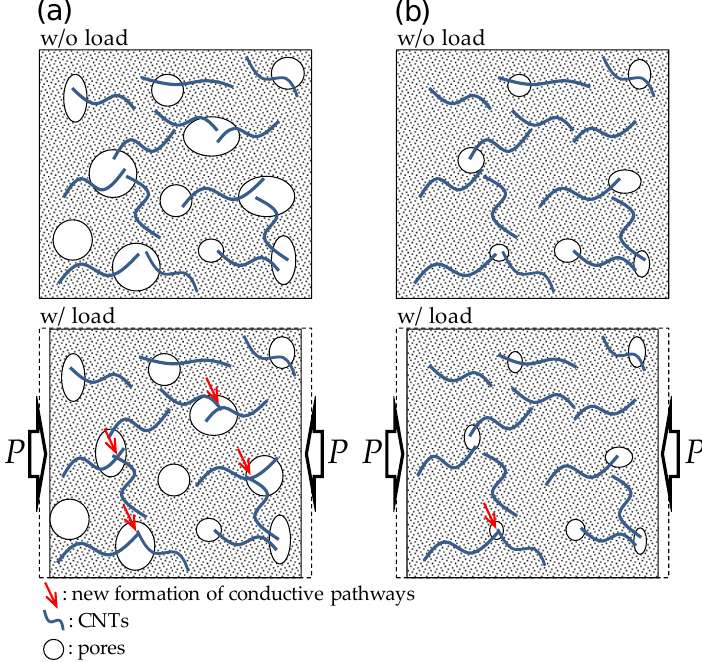
Figure 11. Schematic description of forming new conductive pathways in: ( a ) ordinary cement composites; and ( b ) UHPFRC under compression.